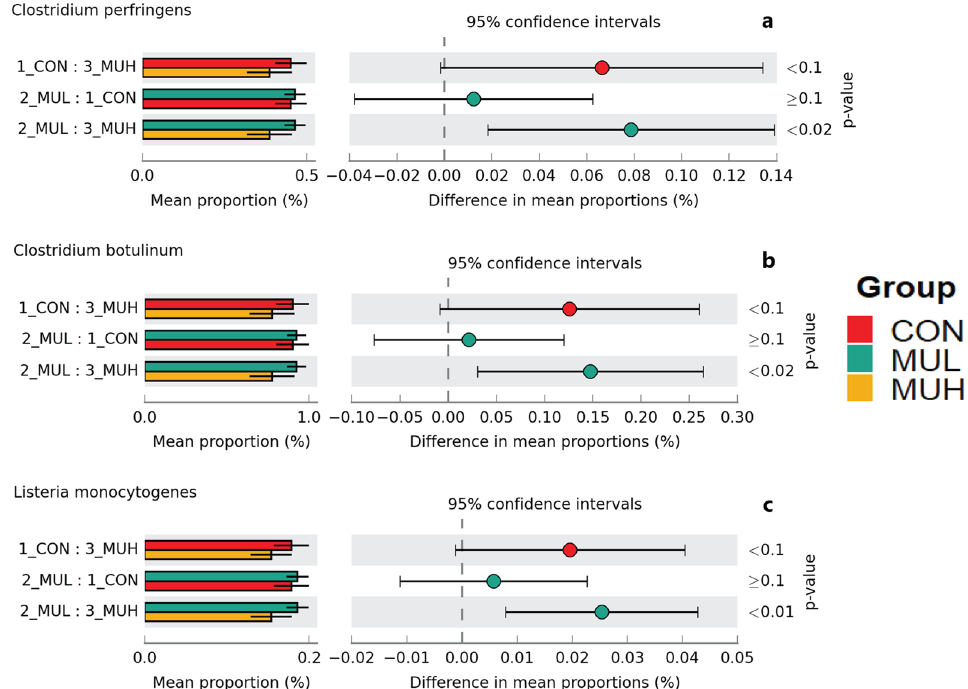
Figure 9. Extended error bar plots of mean relative abundance differences of caecal C. perfringens ( a ), C. botulinum ( b ), and L. monocytogenes ( c ) between CON, MUL, and MUH at slaughter (42 d). Colored bars and black lines indicate the mean relative abundance and standard deviation of the bacterial species, respectively (left side). Colored dots inside the 95% confidence intervals signify the difference of mean relative abundance of the bacterial species for each pairwise comparison (center). Games-Howell post-hoc test p -values are reported (right